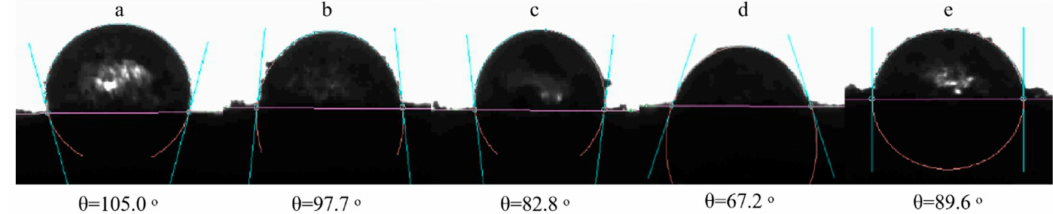
Figure 4. Contact angle measurement of ODF-SPI mixture ( a ) and ODF-SPI conjugates after dry heating at 60 ◦ C for 6 h ( b ), 12 h ( c ), 24 h ( d ) and 48 h ( e